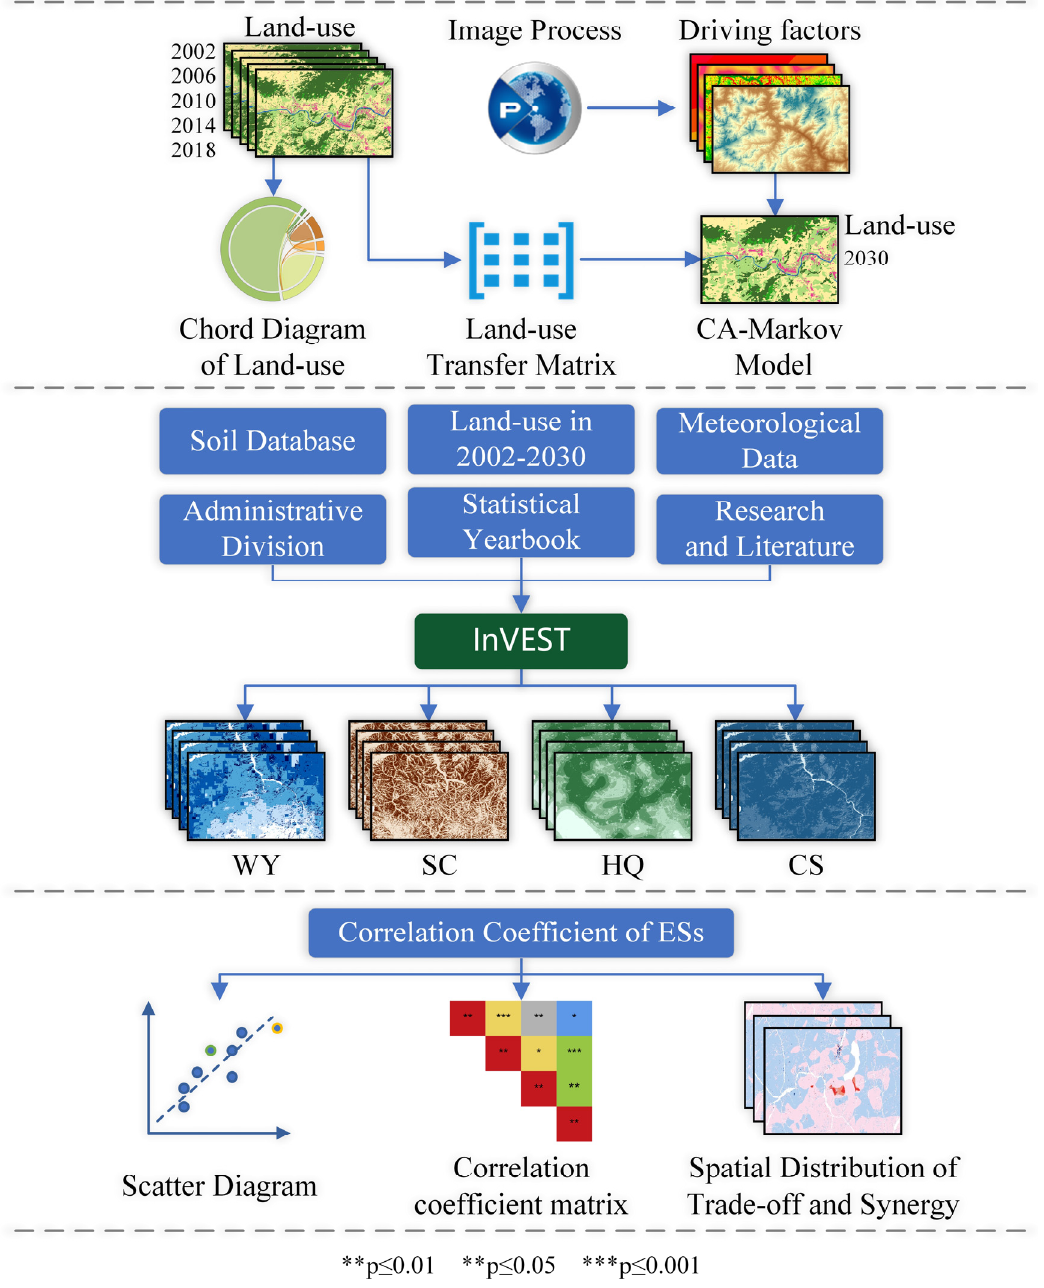
Figure 2. Flow chart of the research framework. Note: WY: water yield; SC: soil conservation; HQ: habitat quality; CS: carbon storage.